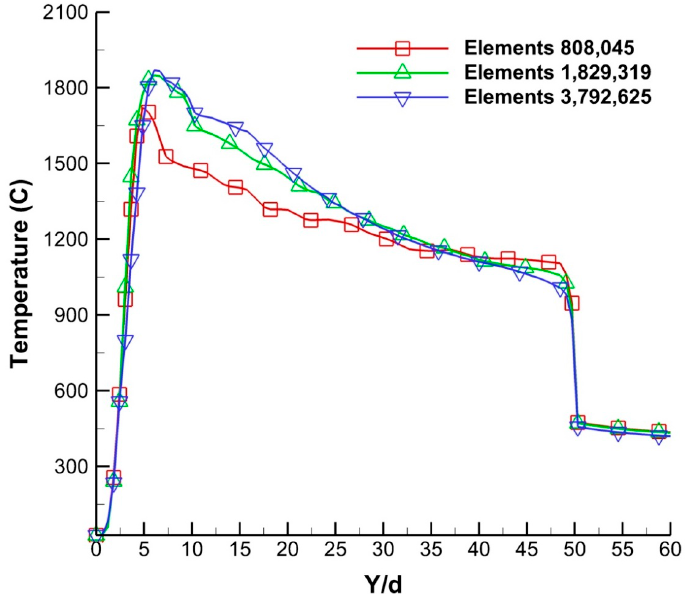
Figure 4. Grid independence check with increasing number of elements.